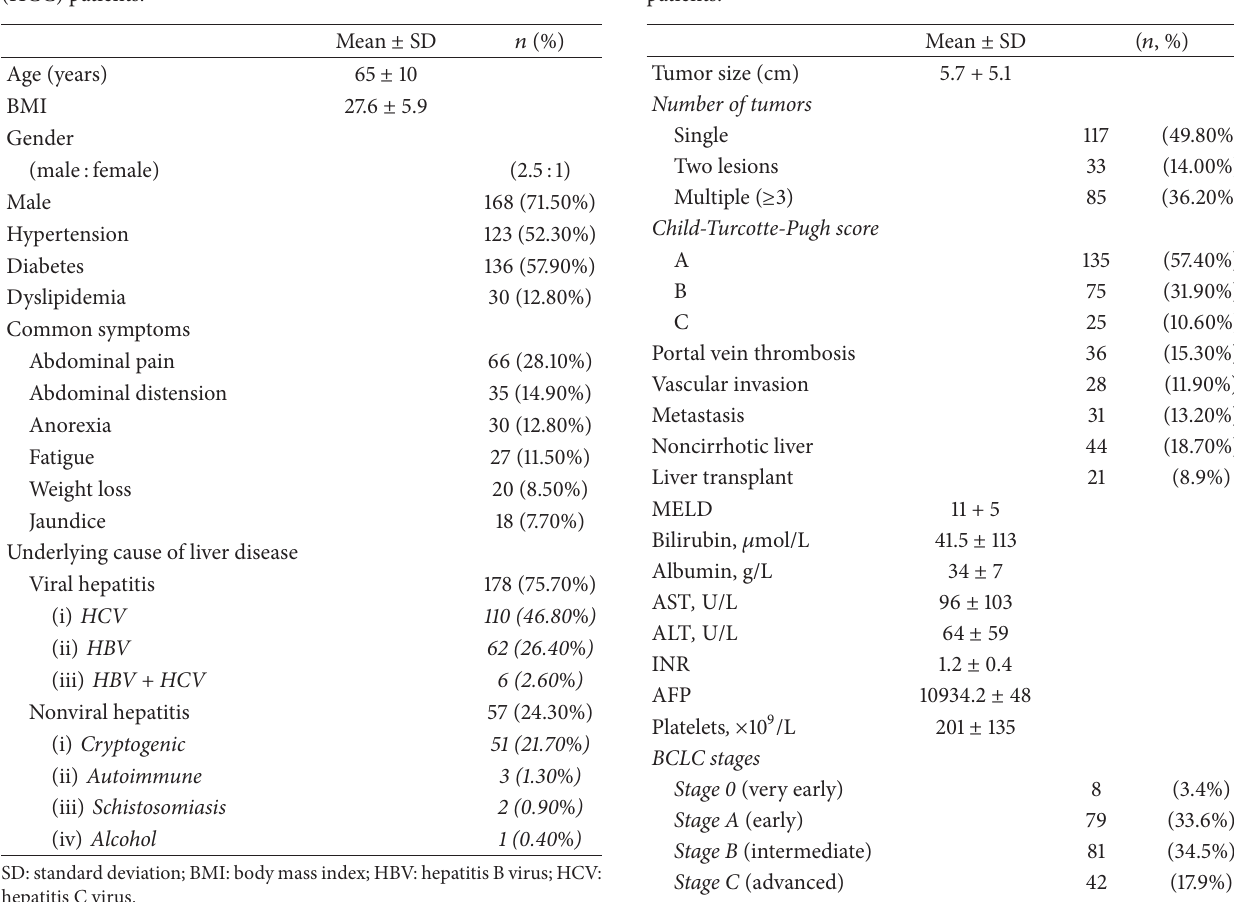
Table 1: General demographic data of hepatocellular carcinoma (HCC) patients.